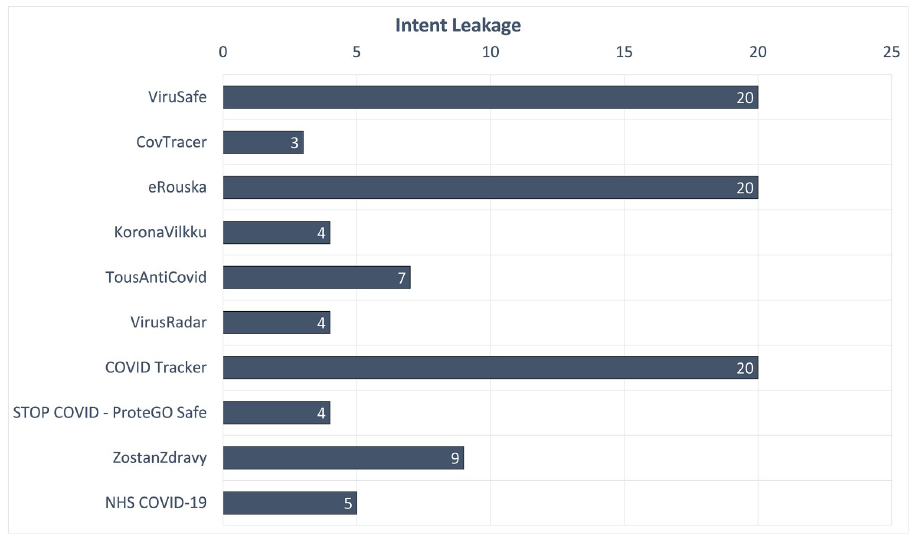
Fig 2. Issues identified through taint